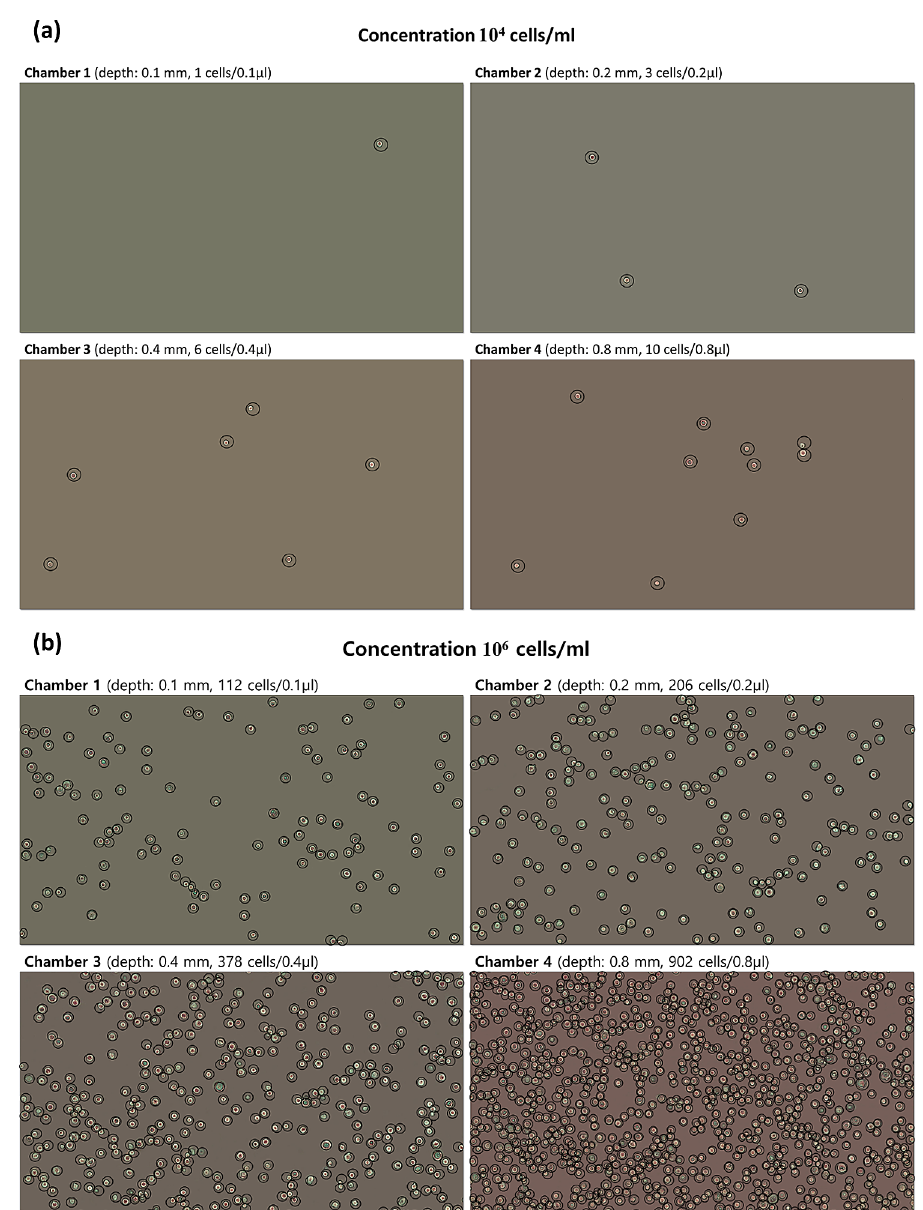
Figure 2. Microscopic cell images in multiple volumes (0.1, 0.2, 0.4, and 0.8 µl) in ( a ) low concentration at 10 4 cells/ml, and ( b ) high concentration at 10 6 cells/ml liquid sample (under 40 ×